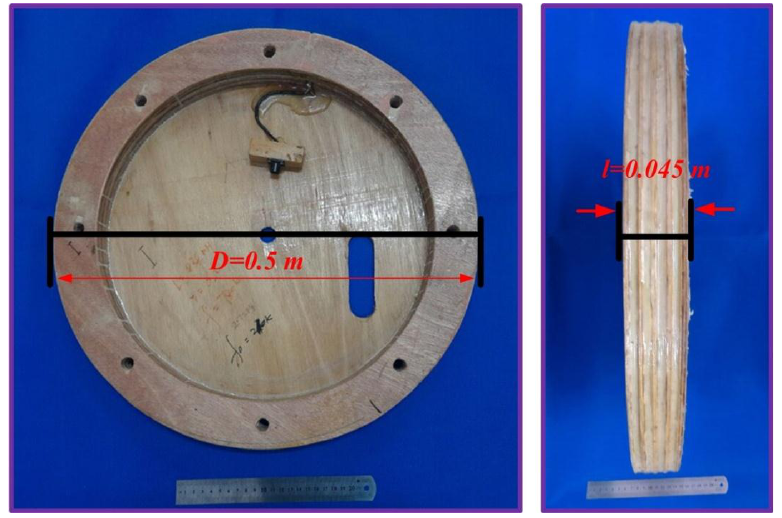
Figure 9. Experimental model of ACS.